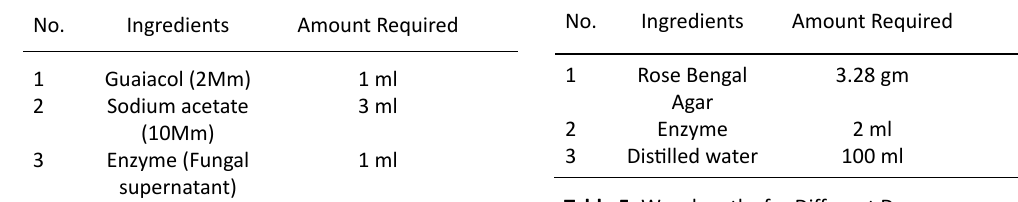
Table 5. Wavelengths for Different Dyes